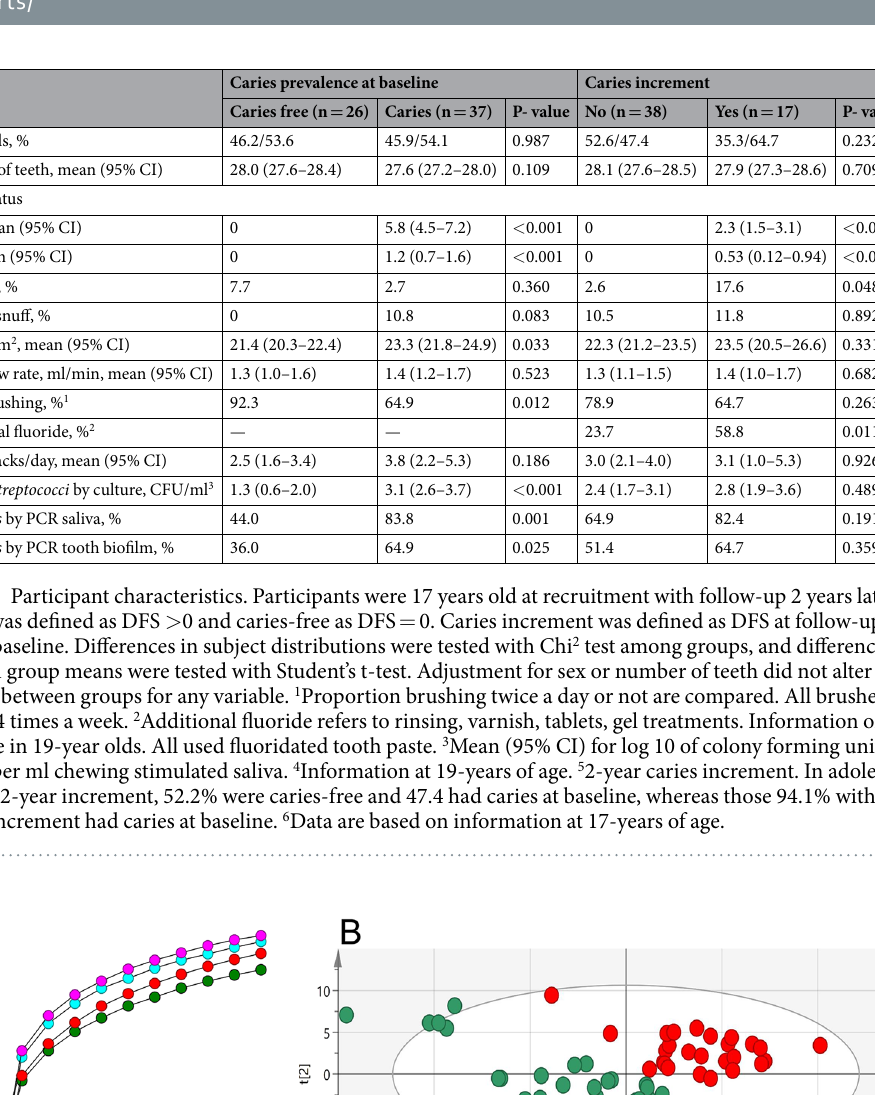
biofilm taxa, and no significant differences were found in univariate analyses between the two groups. However,